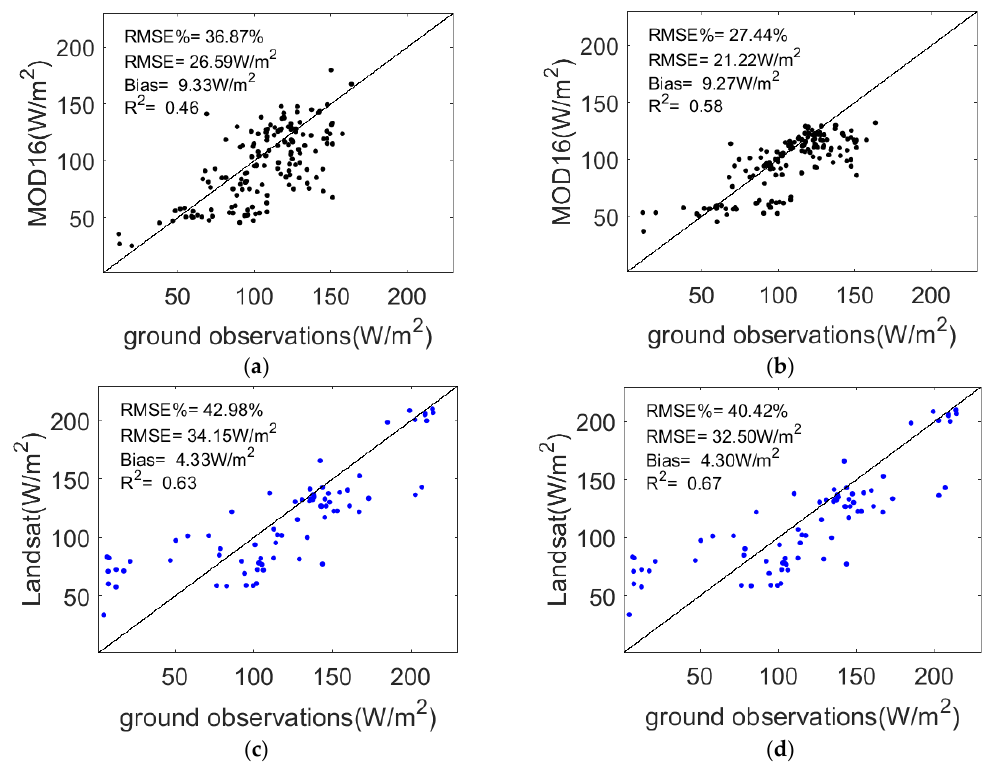
Figure 6. Validations of LE products versus ground observations before and after MKF. ( a ) MOD16 before MKF; ( b ) MOD16 after MKF; ( c ) Landsat-based LE before MKF; ( d ) Landsat-based LE after MKF.